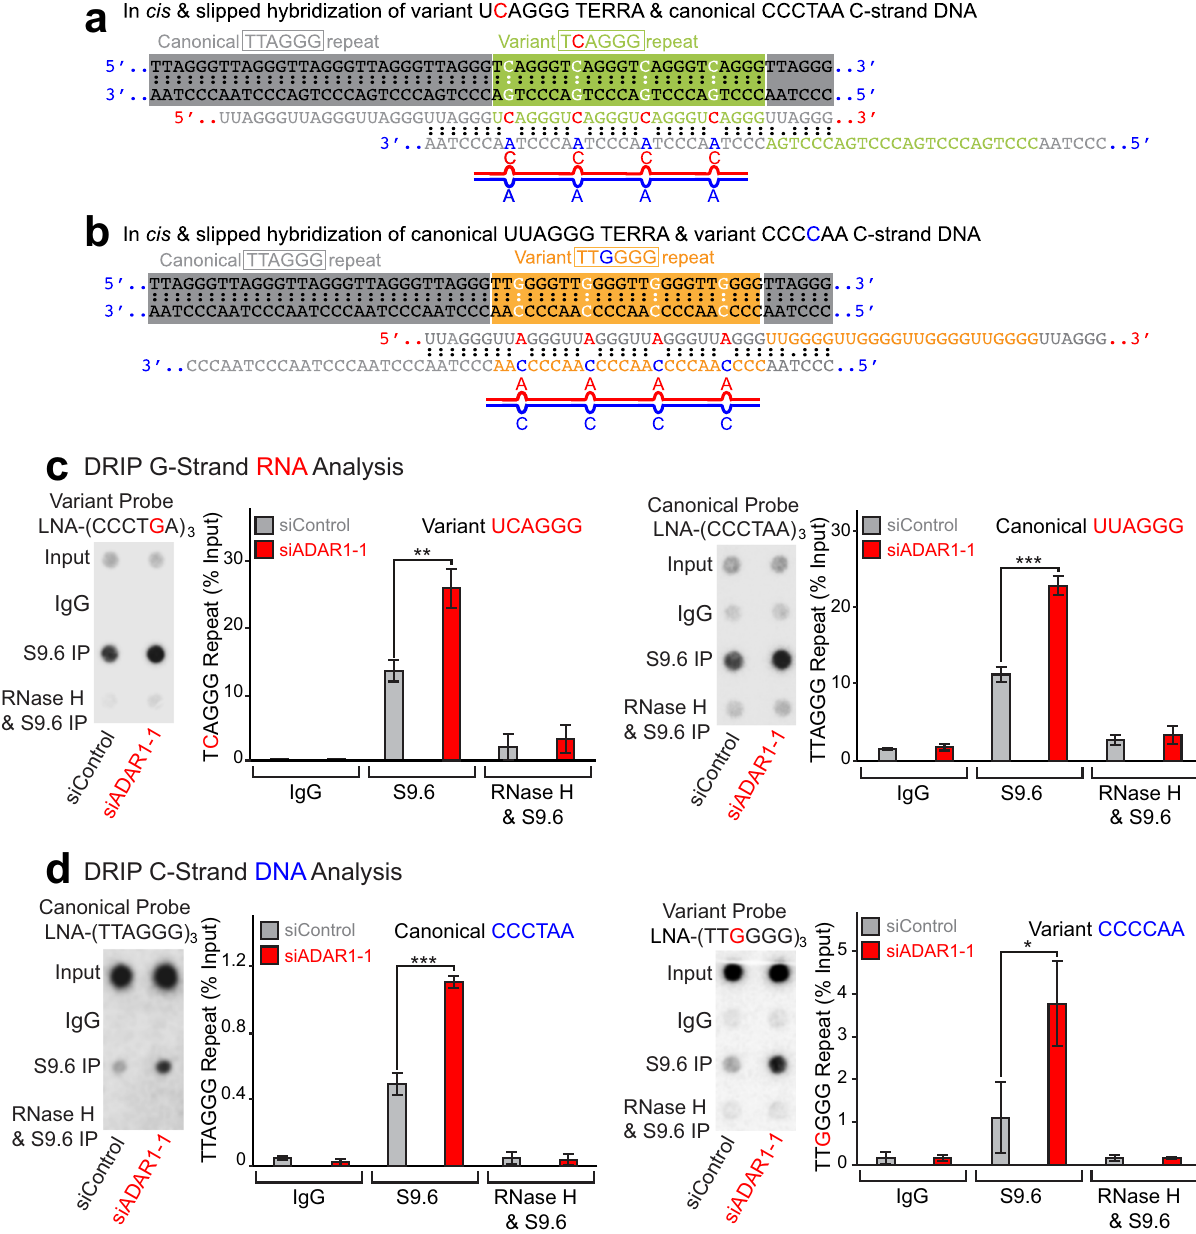
Fig. 6 Increased telomeric RNA:DNA hybrids containing variant repeats in ADAR1-depleted cells. Formation of telomeric repeat RNA:DNA hybrids containing A – C mismatches by in cis slipped hybridization ( a , b ). a TERRA RNAs transcribed from the region containing four TCAGGG (green) variant repeats surrounded by TTAGGG (gray) canonical repeats form an RNA:DNA hybrid containing four C – A mismatches by in cis slipped hybridization to the C-strand DNA containing canonical TTAGGG (CCCTAA) repeats. b TERRA RNAs transcribed from the region containing four TTGGGG (orange) variant repeats surrounded by TTAGGG (gray) canonical repeats form an RNA:DNA hybrid containing four A – C mismatches by in cis slipped hybridization to the C-strand DNA containing TTGGGG (CCCCAA) variant repeats. c , d Detection of increased RNA:DNA hybrids containing TCAGGG and TTGGGG variant repeats in ADAR1-depleted HeLa cells. c DRIP products were examined for G-strand RNAs of UCAGGG variant and UUAGGG canonical repeats by dot blot analysis using high-af fi nity LNA-oligonucleotide probes capable of distinguishing a single-nucleotide mismatch (Supplementary Fig. 4c). d Similarly, DRIP products were examined for C-strand DNAs of TTAGGG (CCCTAA) canonical and TTGGGG (CCCCAA) variant repeats using LNA-oligonucleotide probes capable of distinguishing a single-nucleotide mismatch (Supplementary Fig. 4d). c , d Dot blot signals were abolished by E. coli -RNase H treatment prior to DRIP. The signi fi cance of the increase in RNA:DNA hybrids containing telomeric canonical and variant repeats (RNA and DNA strands) was con fi rmed by conducting three independent dot blot hybridization analysis of DRIP products. Data are mean ± SD ( n = 3, biological replicates); signi fi cant differences were identi fi ed by two-tailed Student ’ s t tests: * P < 0.05, ** P < 0.01, *** P < 0.001. All individual experimental data values and exact P values are presented in Source Data fi